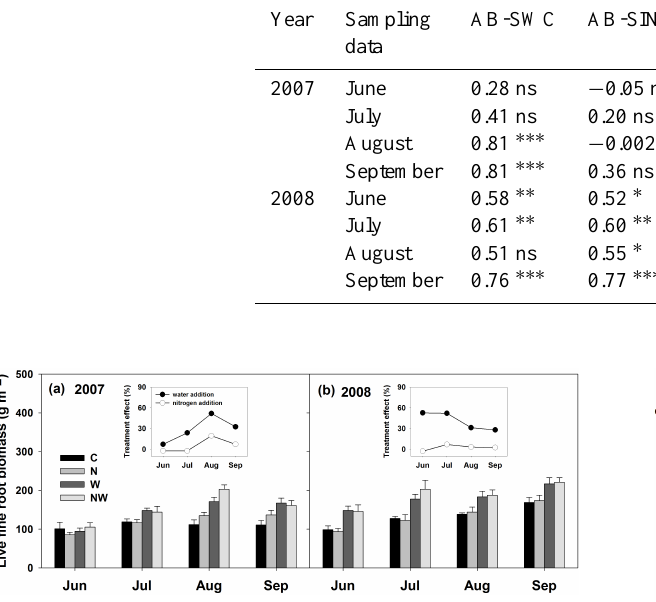
Fig. 3. Responses of live fine root biomass to water addition and nitrogen addition during the growing season in 2007 (a) and 2008 (b) . Main effects of each treatment are shown in the insets. Data are presented as mean ± SE ( n = 5). C is for control, N for nitrogen ad- dition, W for water addition, and NW for nitrogen+water addition.